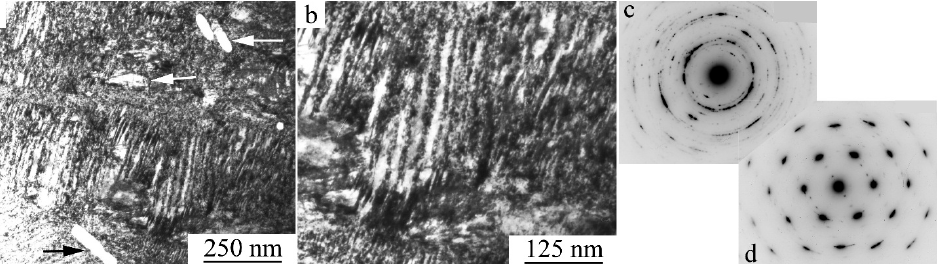
Figure 24. ( a ) Bright- and ( b ) dark-field TEM images, and ( c , d ) SAED patterns (( c )—SD 1.0 µm, ( d )—z.a. close to [111] В 2 || [110] B 19’ || [111] R , SD 0.3 µm), taken from the Ti 49 Ni 51 alloy after MPR by 30% and PDHT at 573 К for 1 h. Arrows show the particles of Ti 4 Ni 2 O x .